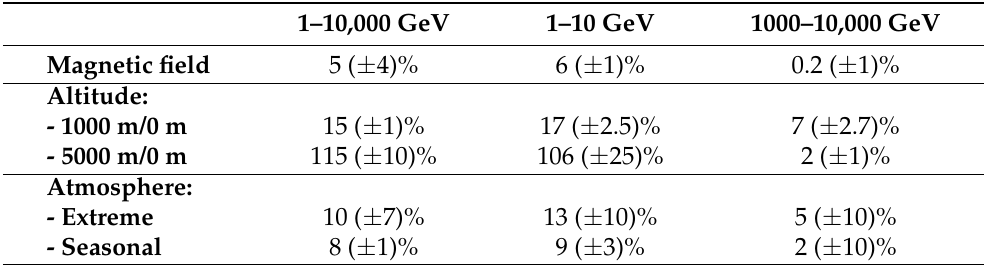
Table 2. Maximum observed variations comparing two CORSIKA fluxes for the studied effects: magnetic field, altitude and state of the atmosphere (extreme and seasonal effect) for several muon energy